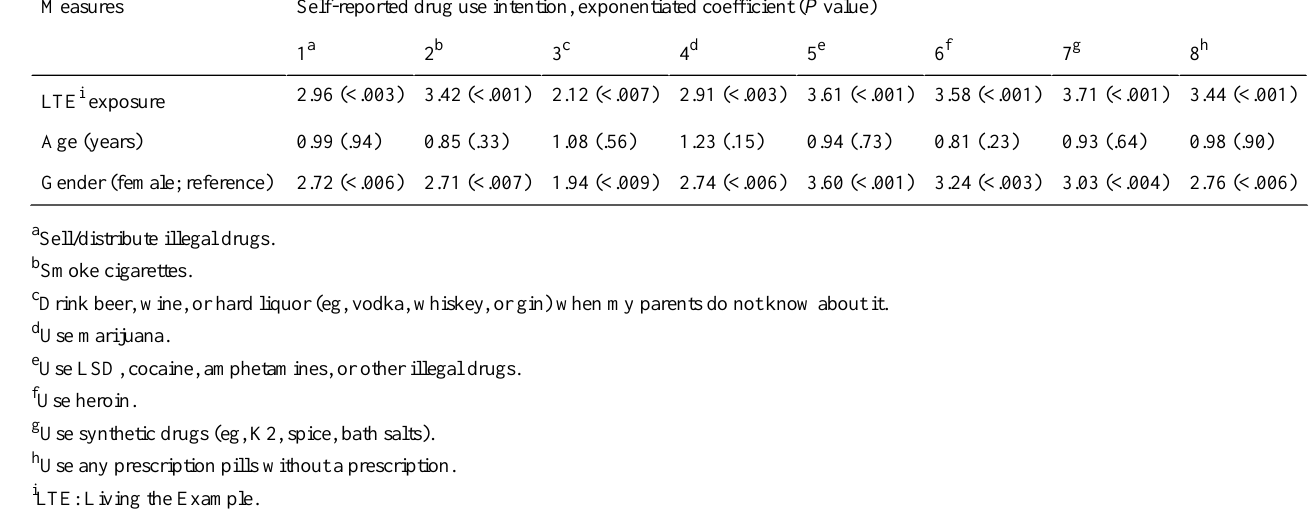
Table 2. Logistic regressions of drug use intentions on Living the Example program exposure at wave 3, exponentiated coefficient (n=542). Self-reported drug use intention, exponentiated coefficient ( P